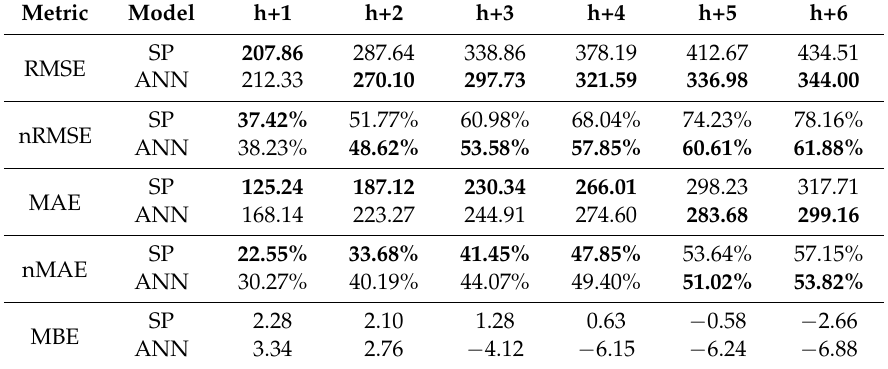
Table 7. Performance metrics (in Wh/m 2 for RMSE, MAE, and MBE) for DNI (in bold is the best predictor for each horizon and each error metric) (Odeillo site).